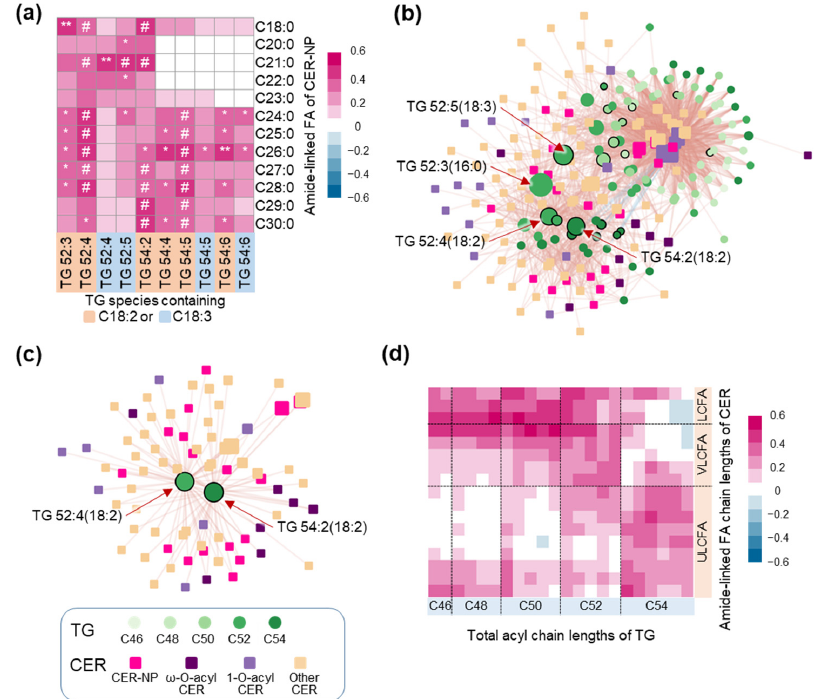
Figure 3. The association of skin surface overall ceramides (CER) including CER-NP and triacyl- glycerols (TG). Non-hydroxy fatty acid (FA) [N], Phytosphingosine [P]. ( a ) Spearman correlation heatmap between CER-NP and C52–54 TG species containing C18:2 or C18:3. * p < 0.05, ** p < 0.01 and # adjusted p < 0.05; adjusted p value was calculated using the Benjamini–Hochberg (BH) method to correct multiple tests. ( b ) Network was built with Spearman correlation coefficients (>0.3) between CER species and TG species. Node size indicates betweenness value and nodes with black border line indicating TG containing C18:2 or C18:3. ( c ) Sub network showing CER directly connected to TG 52:4(18:2) or TG 54:2(18:2). ( d ) Spearman correlation heatmap between CER categorized